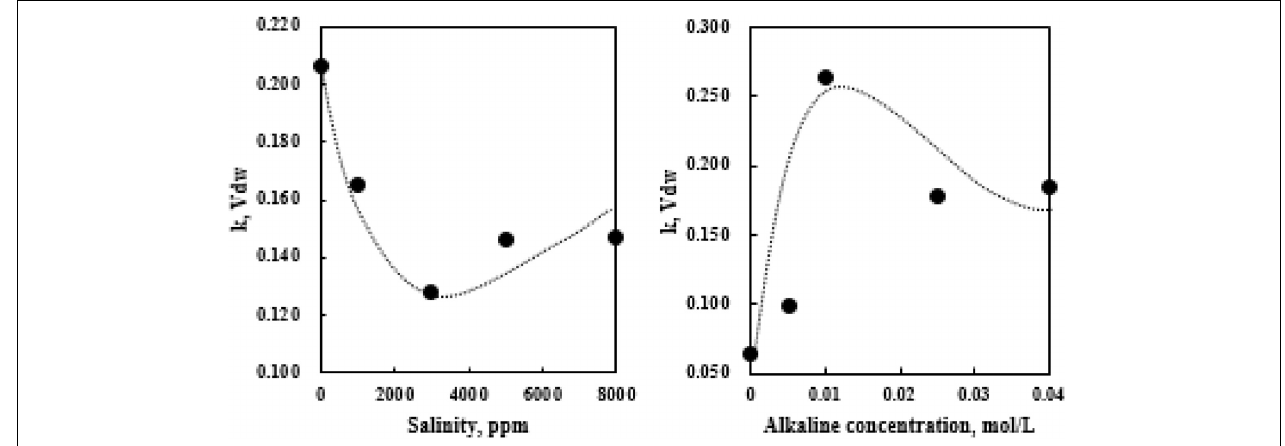
TABLE 9 | Sandpack alkaline flooding test strategies.